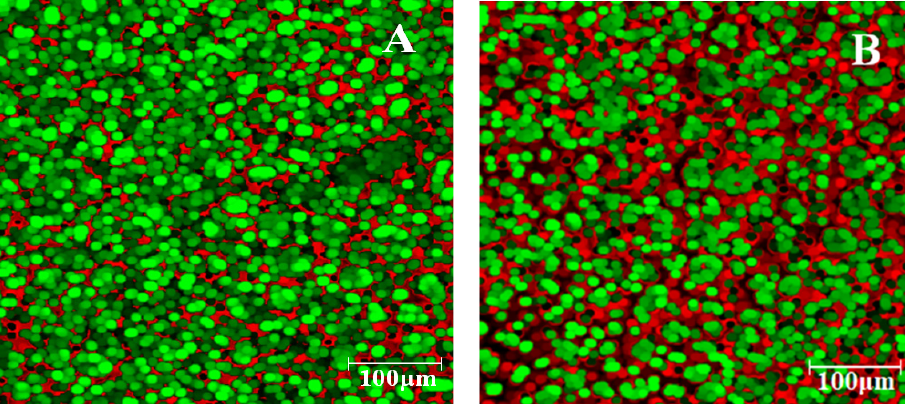
Figure 11. Dough microstructure of ( A ) wheat control sample ( B ) optimal combination of CGF, LGF, and wheat flour.